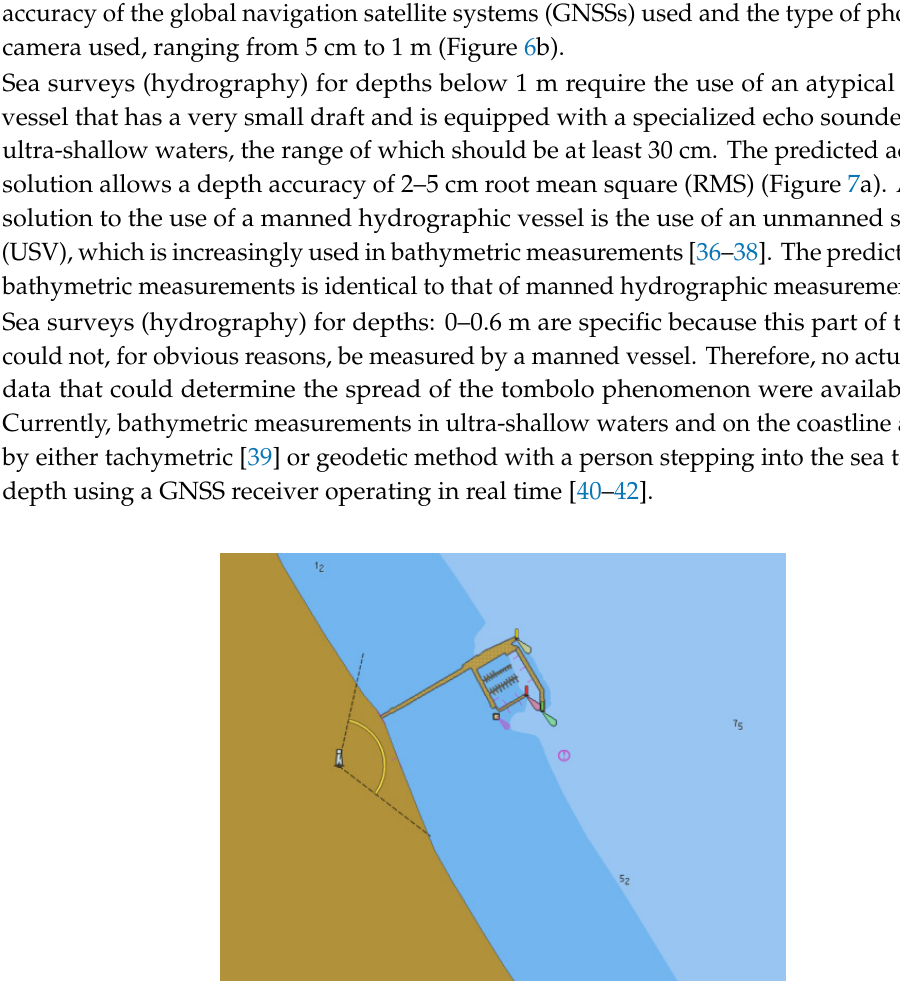
Figure 5. Bathymetric chart of the marina area in Sopot made on the basis of official electronic navigational chart (ENC) data.